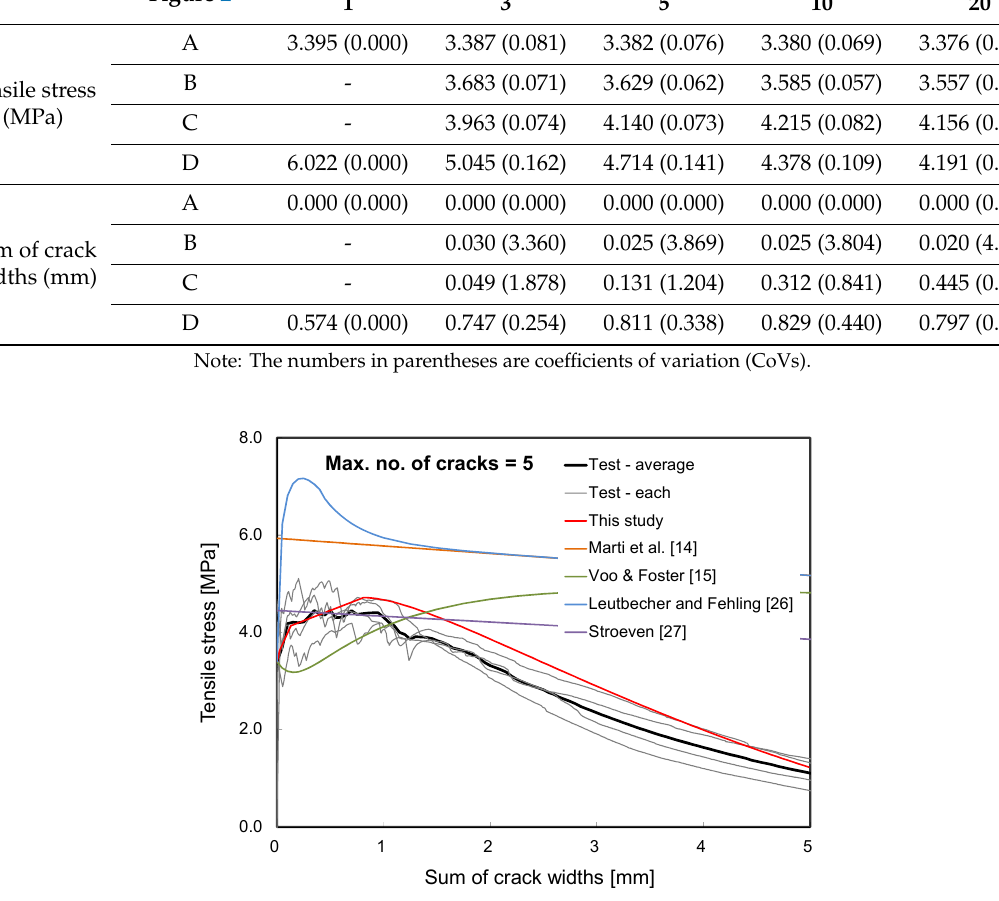
Figure 11. Comparison with FRC tension models. 402